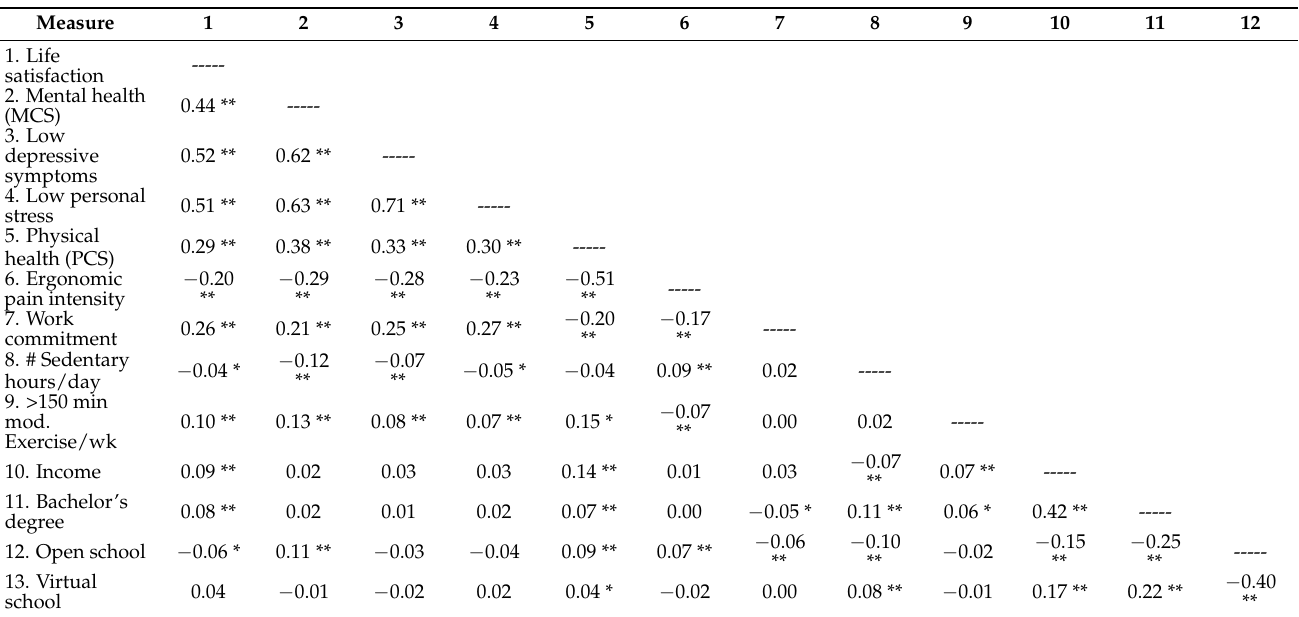
Table 3. Zero-Order Correlations for Study